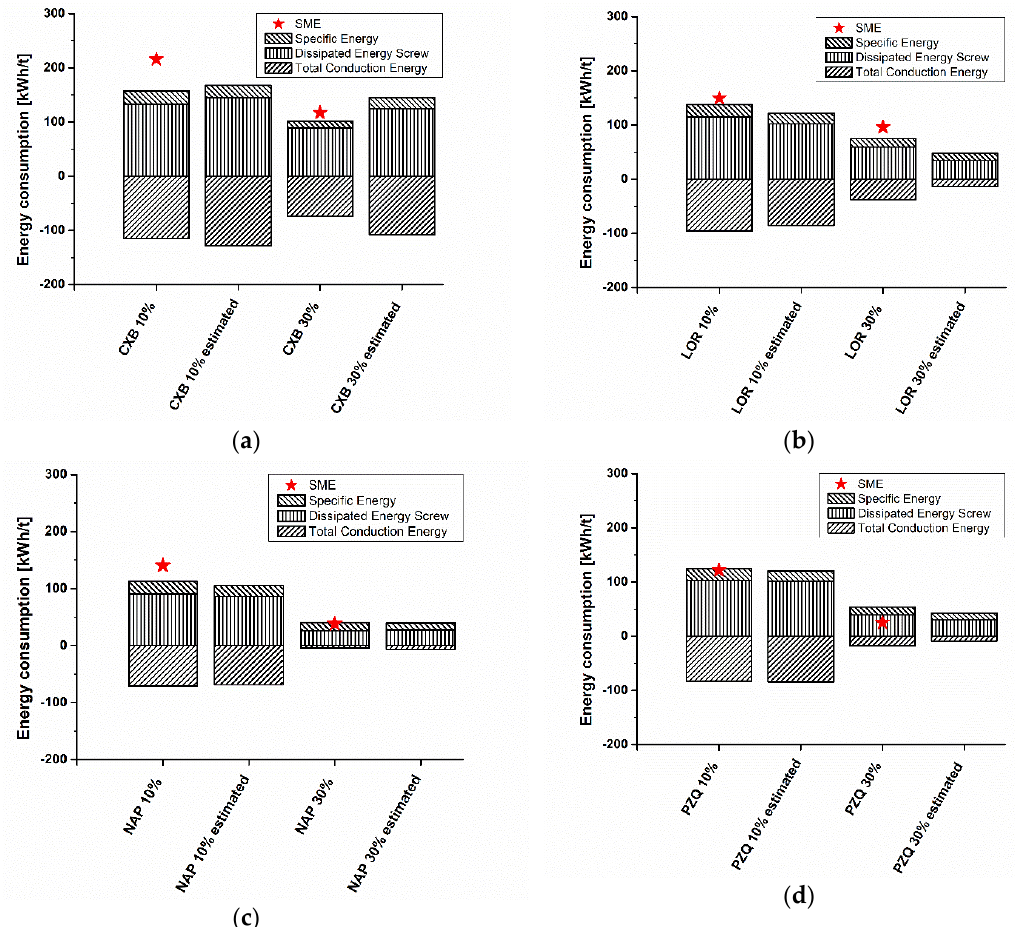
Figure 5. Energy consumption in hot-melt extrusion (HME) experiments, conventional simulation, and simulation using model-based melt viscosity at 150 °C extrusion temperature for celecoxib ( a ), loratadine ( b ), naproxen ( c ), and praziquantel ( d ) in copovidone.